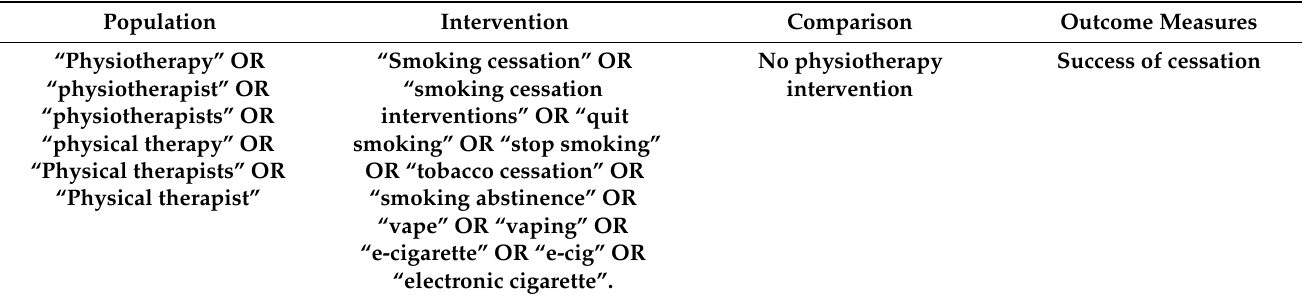
Table 1. Keywords and search strategy used, using the PICO approach in the selected